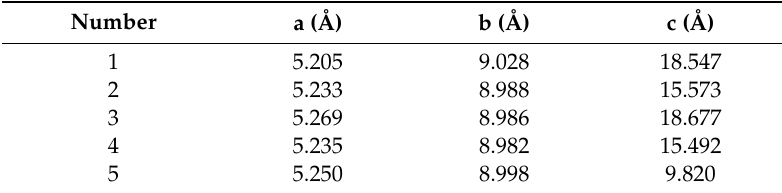
Figure 6. X-ray powder-diffraction patterns for montmorillonite samples.